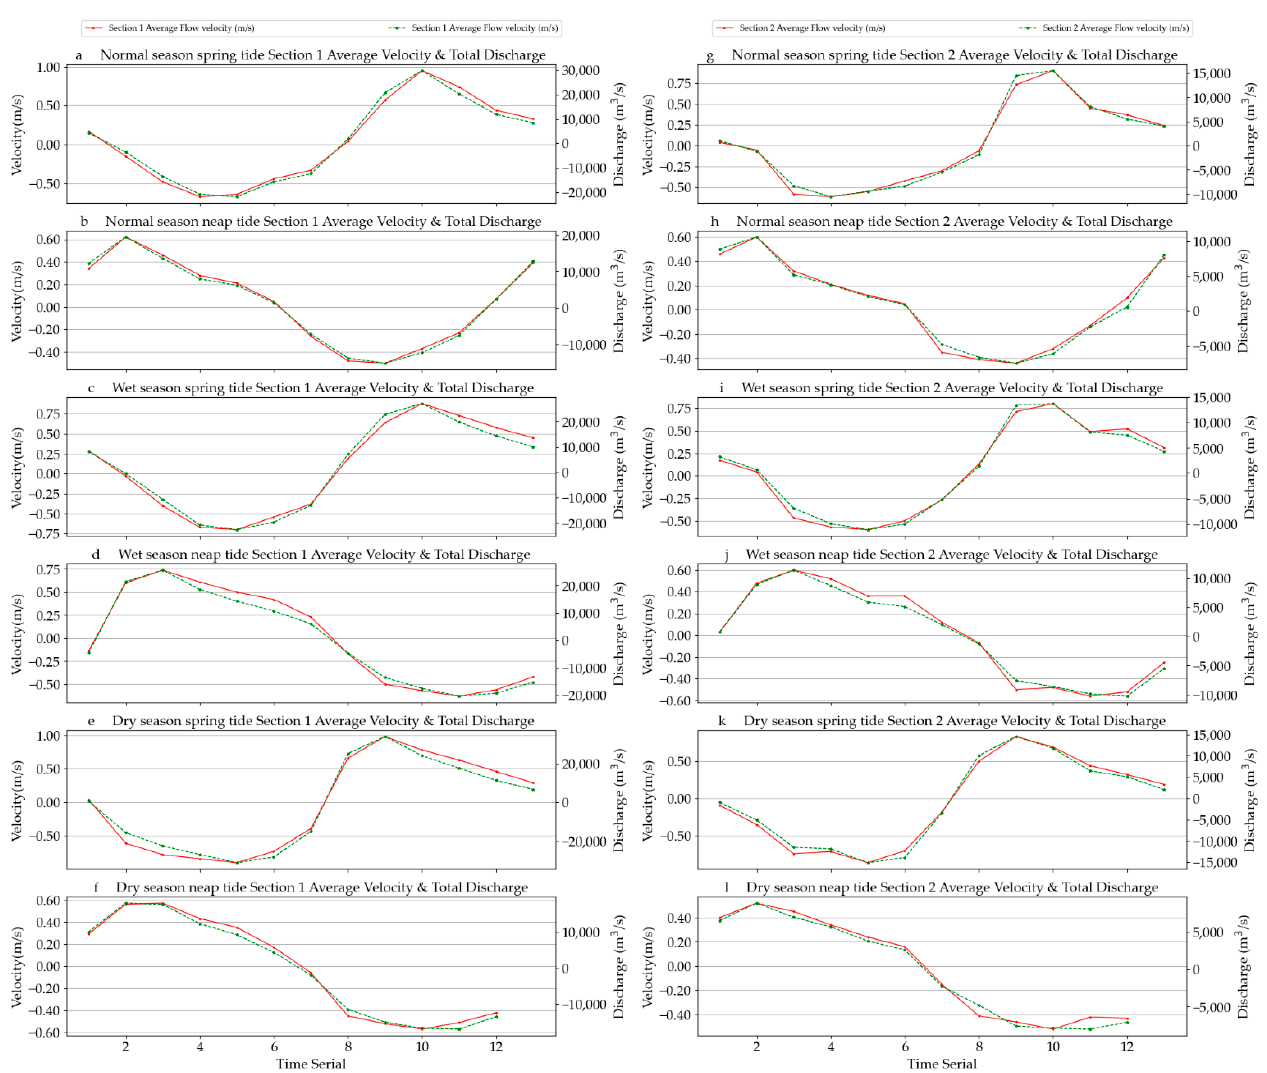
Figure 5. Process curve of the average velocity and total discharge of two sections at the spring tide and neap tide during the normal season, wet season, and dry season. ( a ) Normal season spring tide average velocity & total discharge of section 1, ( b ) Normal season neap tide average velocity & total discharge of section 1, ( c ) Wet season spring tide average velocity & total discharge of setion 1, ( d ) Wet season neap tide average velocity & total discharge of section 1, ( e ) Dry season spring tide average velocity & total discharge of section 1, ( f ) Dry season neap tide average velocity & total discharege of section 1, ( g ) Normal season spring tide average velocity & total discharge of section 2, ( h ) Normal season neap tide average velocity & total discharge of section 2, ( i ) Wet season spring tide average velocity & total discharge of setion 2, ( j ) Wet season neap tide average velocity & total discharge of section 2, ( k ) Dry season spring tide average velocity & total discharge of section 2, ( l ) Dry season neap tide average velocity & total discharege of section